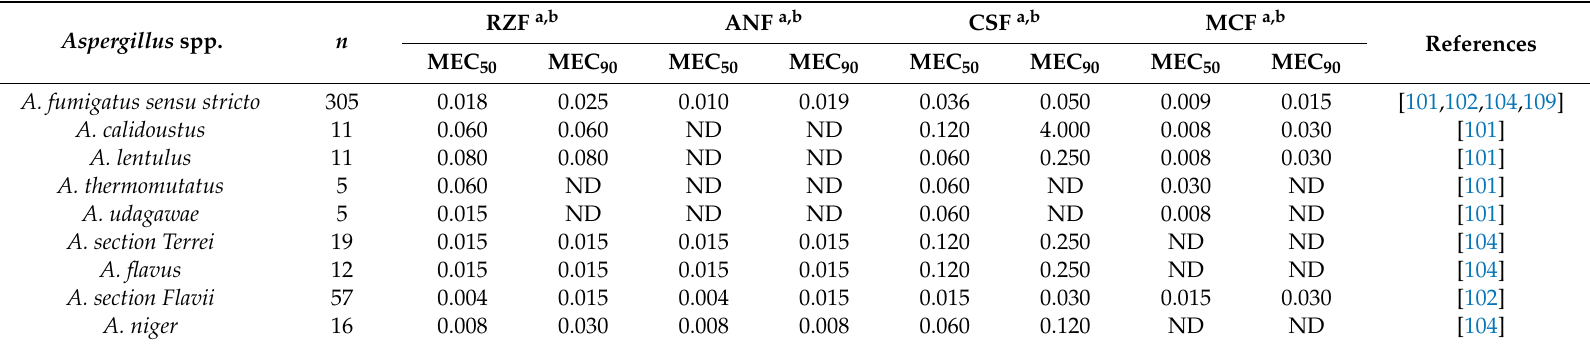
Table 3. Rezafungin and FDA-approved echinocandin MEC values for Aspergillus spp. determined by CLSI microdilution reference methods. Aspergillus